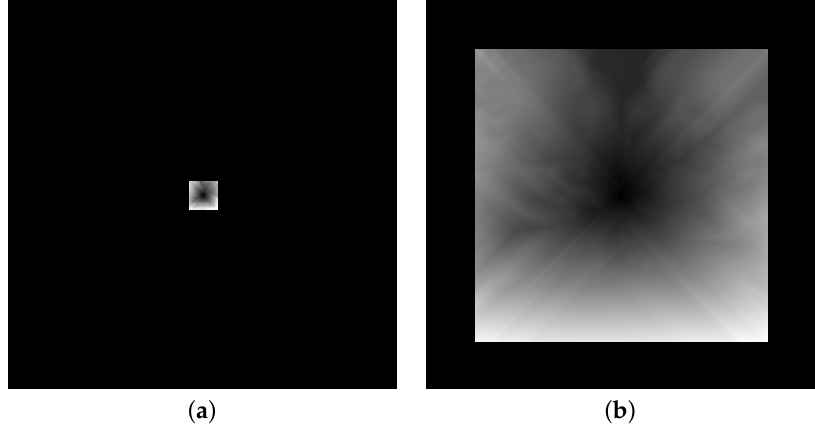
Figure 6. Visualization of time taken to reach the cells in ( a ) 30 ticks and ( b ) 300 ticks. After the simulation is done, each cell of the grid has a value assigned—a positive num- ber denoting the time taken to reach the cell from the initial cell. We use gdal-contour